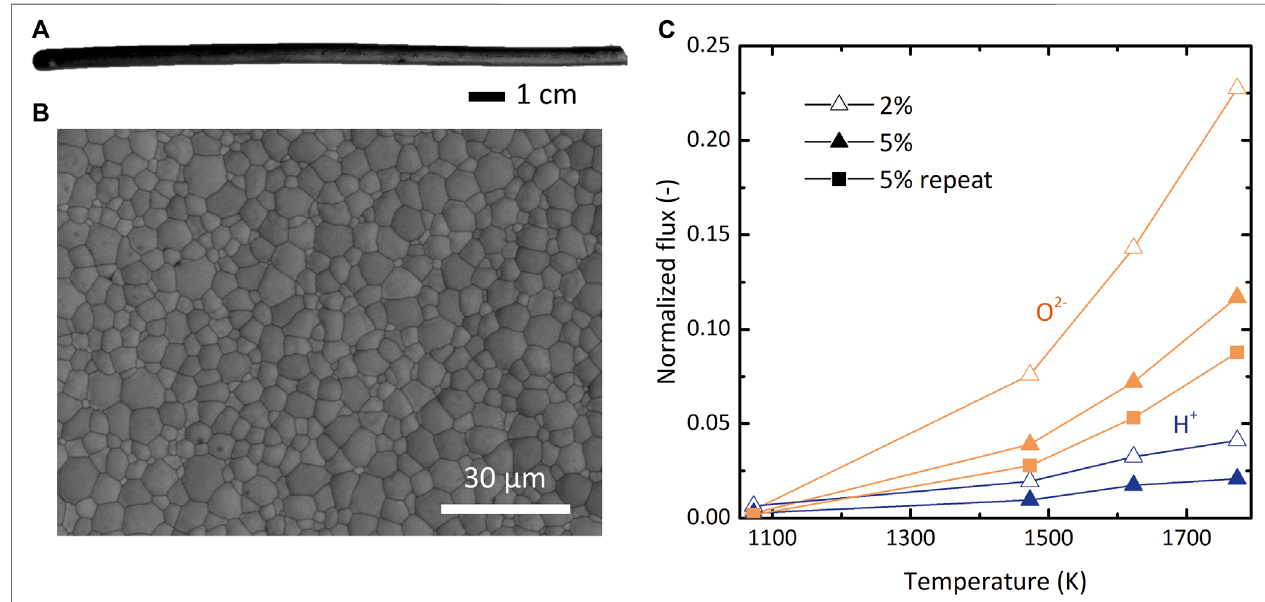
FIGURE 8 | (A) Photograph of a representative BCZY27 membrane, which were tubular and closed on one end. (B) Scanning electron microscopic image of the inner surface of a BCZY27 membrane. (C) Normalized ionic fl ux of H + (blue) and O 2 − (orange) at the respective H 2 or O 2 feed gas concentrations of 2% (hollow) and 5% (solid) through a BCZY27 membrane as a function of T . A repetition of 5% O 2 feed with a different membrane is shown with square symbols.